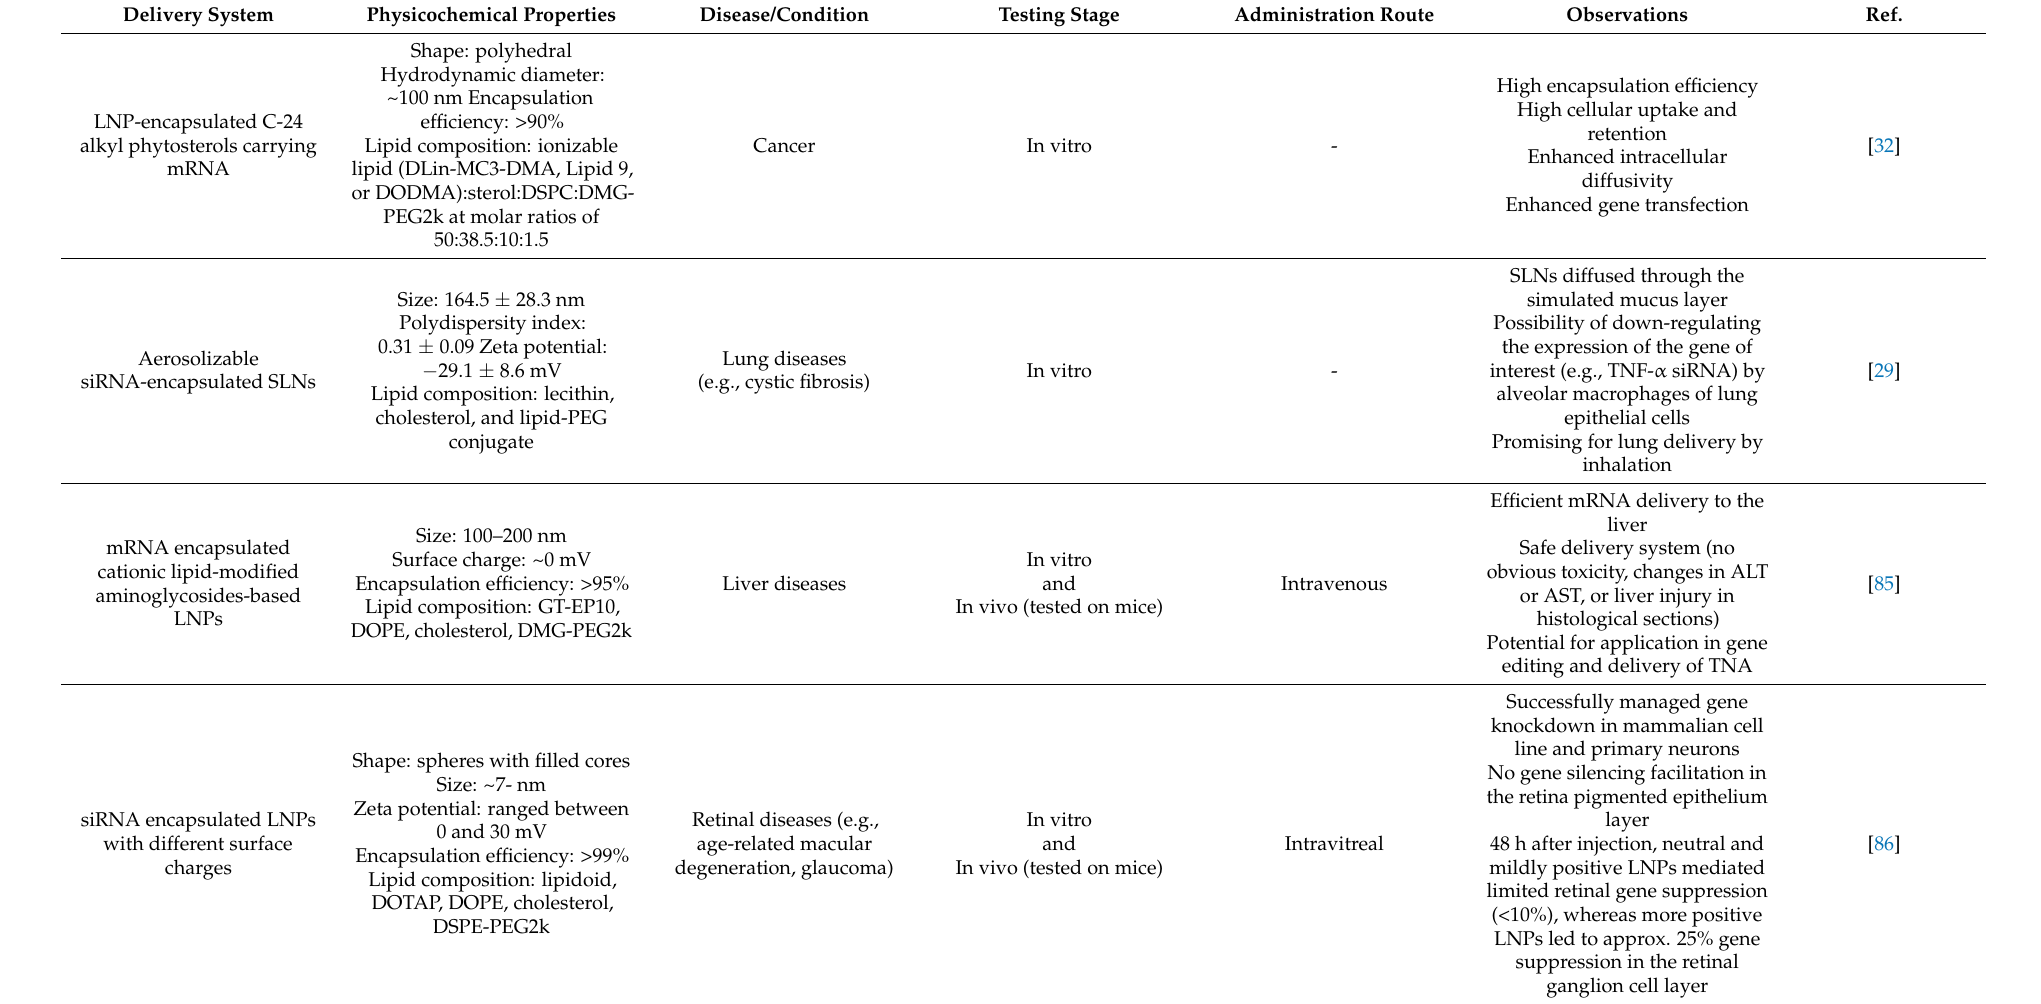
Table 1. A summary of lipid-based nucleic acids delivery systems